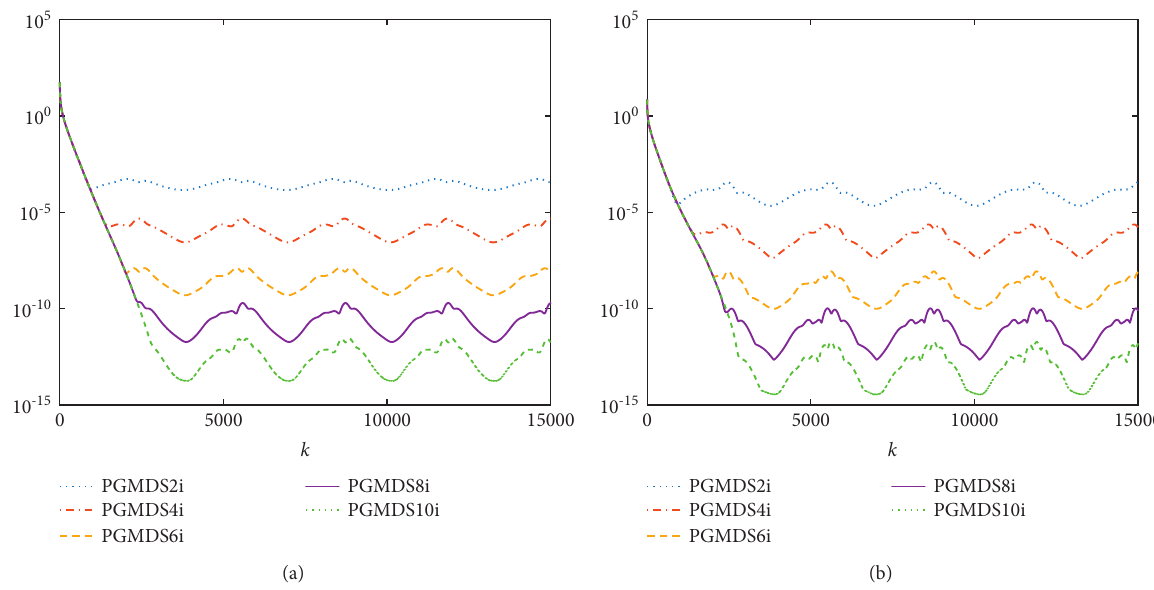
Figure 14: Residual error trajectories synthesized by five PGMDS algorithms for example 3 (with ϵ � 0 . 002 s and c � 5 . 0). (a) Trajectories of A − I ‖ ‖ X . (b) Trajectories of ‖ X k + k + 1 k + 1 F